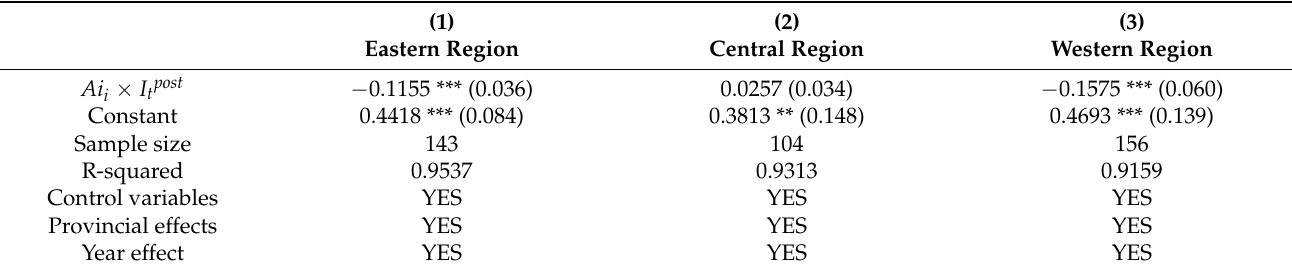
Table 6. Results in different natural geographical locations.